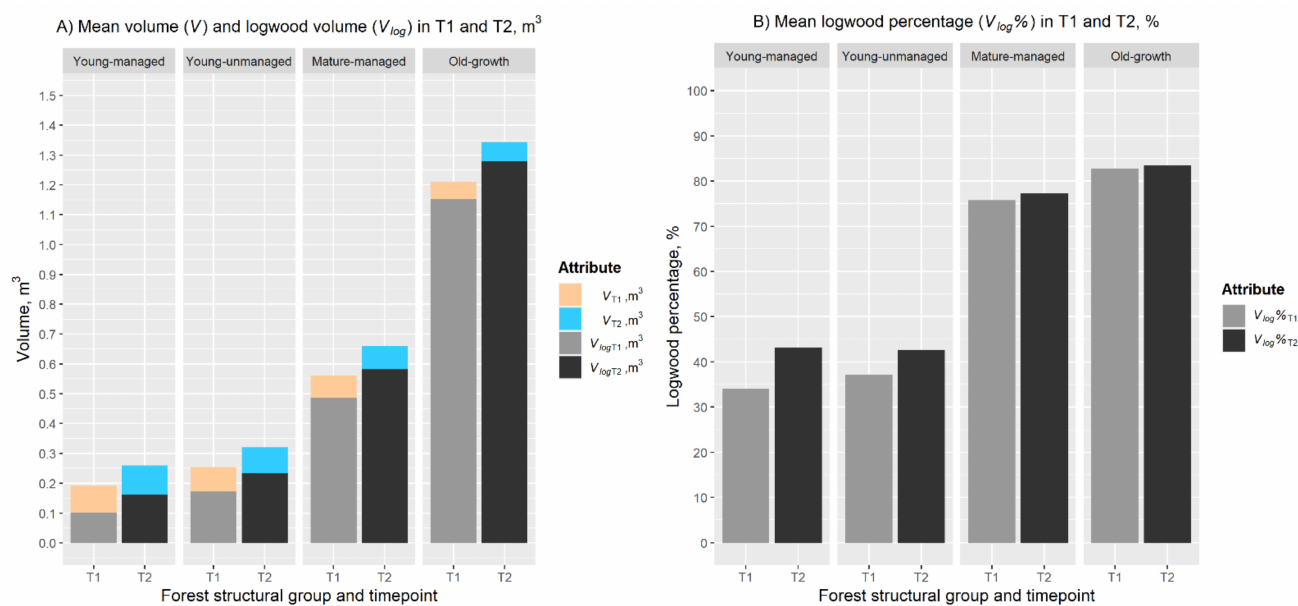
Figure 4. ( A ) Mean stem volume and logwood volume of trees in different forest structural groups in T1 and T2. The bars represent the mean stem volume ( V , m 3 ) and mean logwood volume ( V log , m 3 ) in T1 and T2 within forest structural groups young-managed, young-unmanaged, mature-managed, and old-growth, respectively. ( B ) Mean logwood percentage ( V log % , %) in T1 and T2 within the forest structural groups used in the